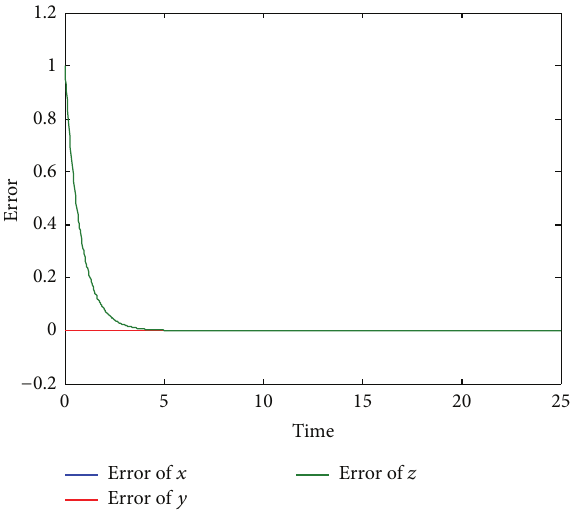
Figure 20: Position Error of quadrotor with input